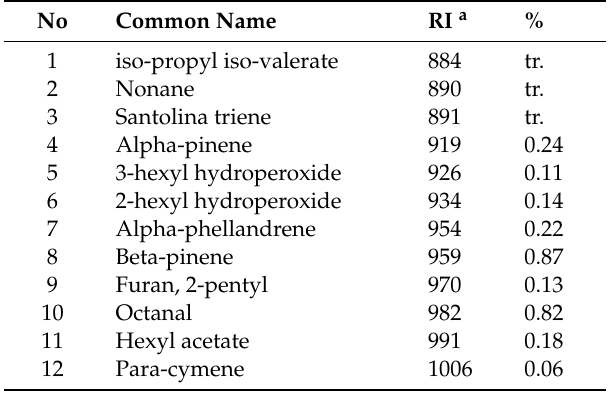
Table 1. The chemical composition of the EO extracted from P. sylvestris